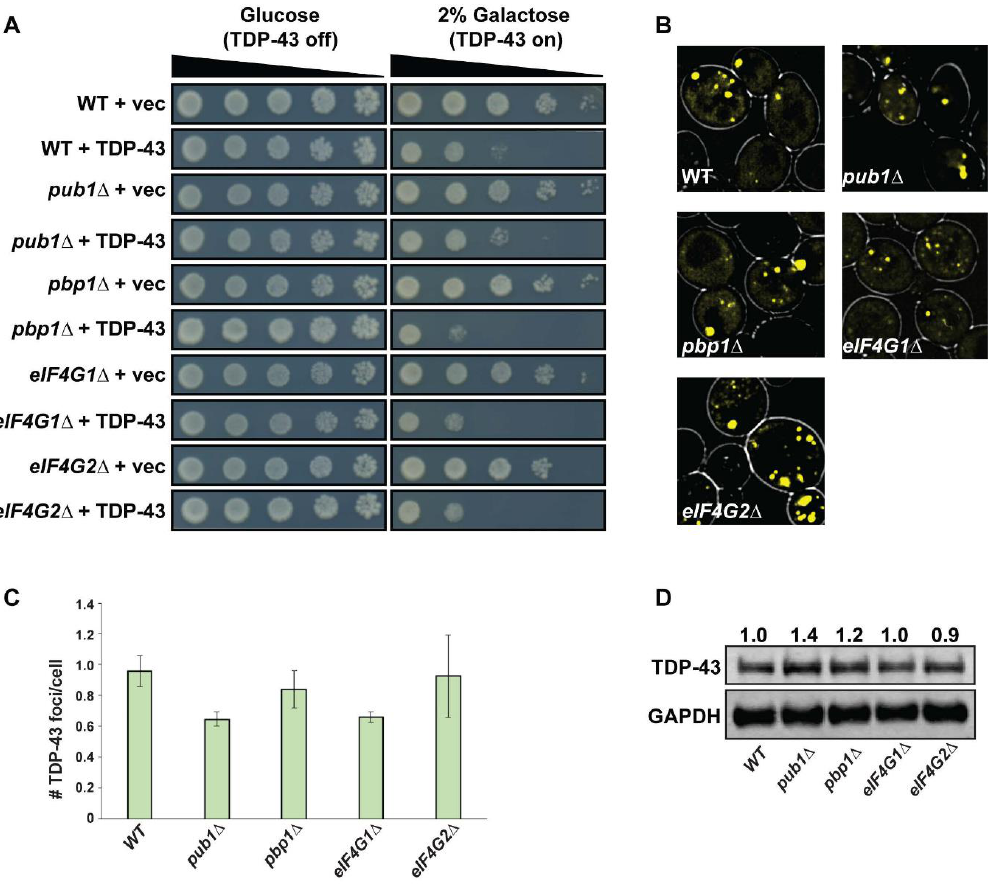
Figure 2. SG assembly mutants do not strikingly a ff ect TDP-43 toxicity, foci formation or abundance. ( A ) BY4741 (WT) and indicated strains were transformed with pRB109 expressing TDP-43-YFP and examined for TDP-43 toxicity by serial dilution spotting assay. ( B ) The strains mentioned above were examined for the presence of TDP-43 foci. ( C ) Quantification of ( B ); number of TDP-43-YFP foci / cell. Data generated from 3 biological replicates with mean ± s.d shown. ( D ) Western analysis of above strains to assess steady-state TDP-43-YFP protein levels; quantification, based on two biological replicates, is normalized to GAPDH loading